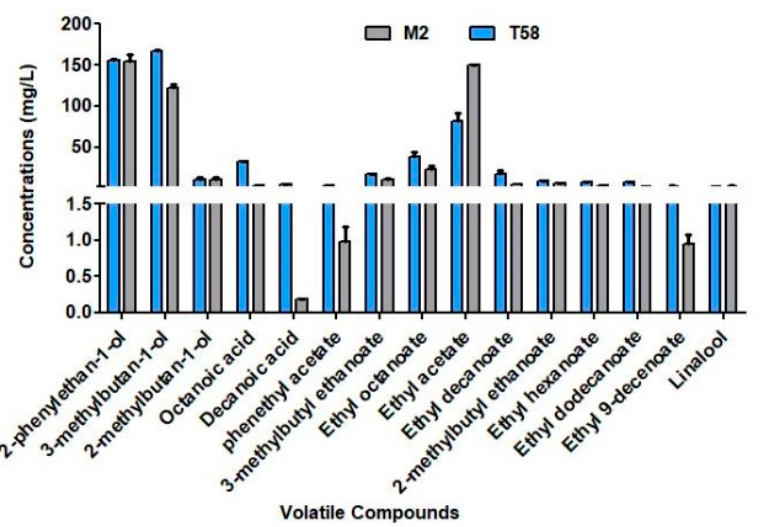
Figure 4. Concentrations of volatiles organic compounds in conditioned beers M2 and T58. Data are reported as means ± SD. Where not visible, error bars lie below the symbols. Histogram bar with two segments option was generated by using GraphPad Prism software (GraphPad Prism 5.03 GraphPad Software Inc., La Jolla, CA,